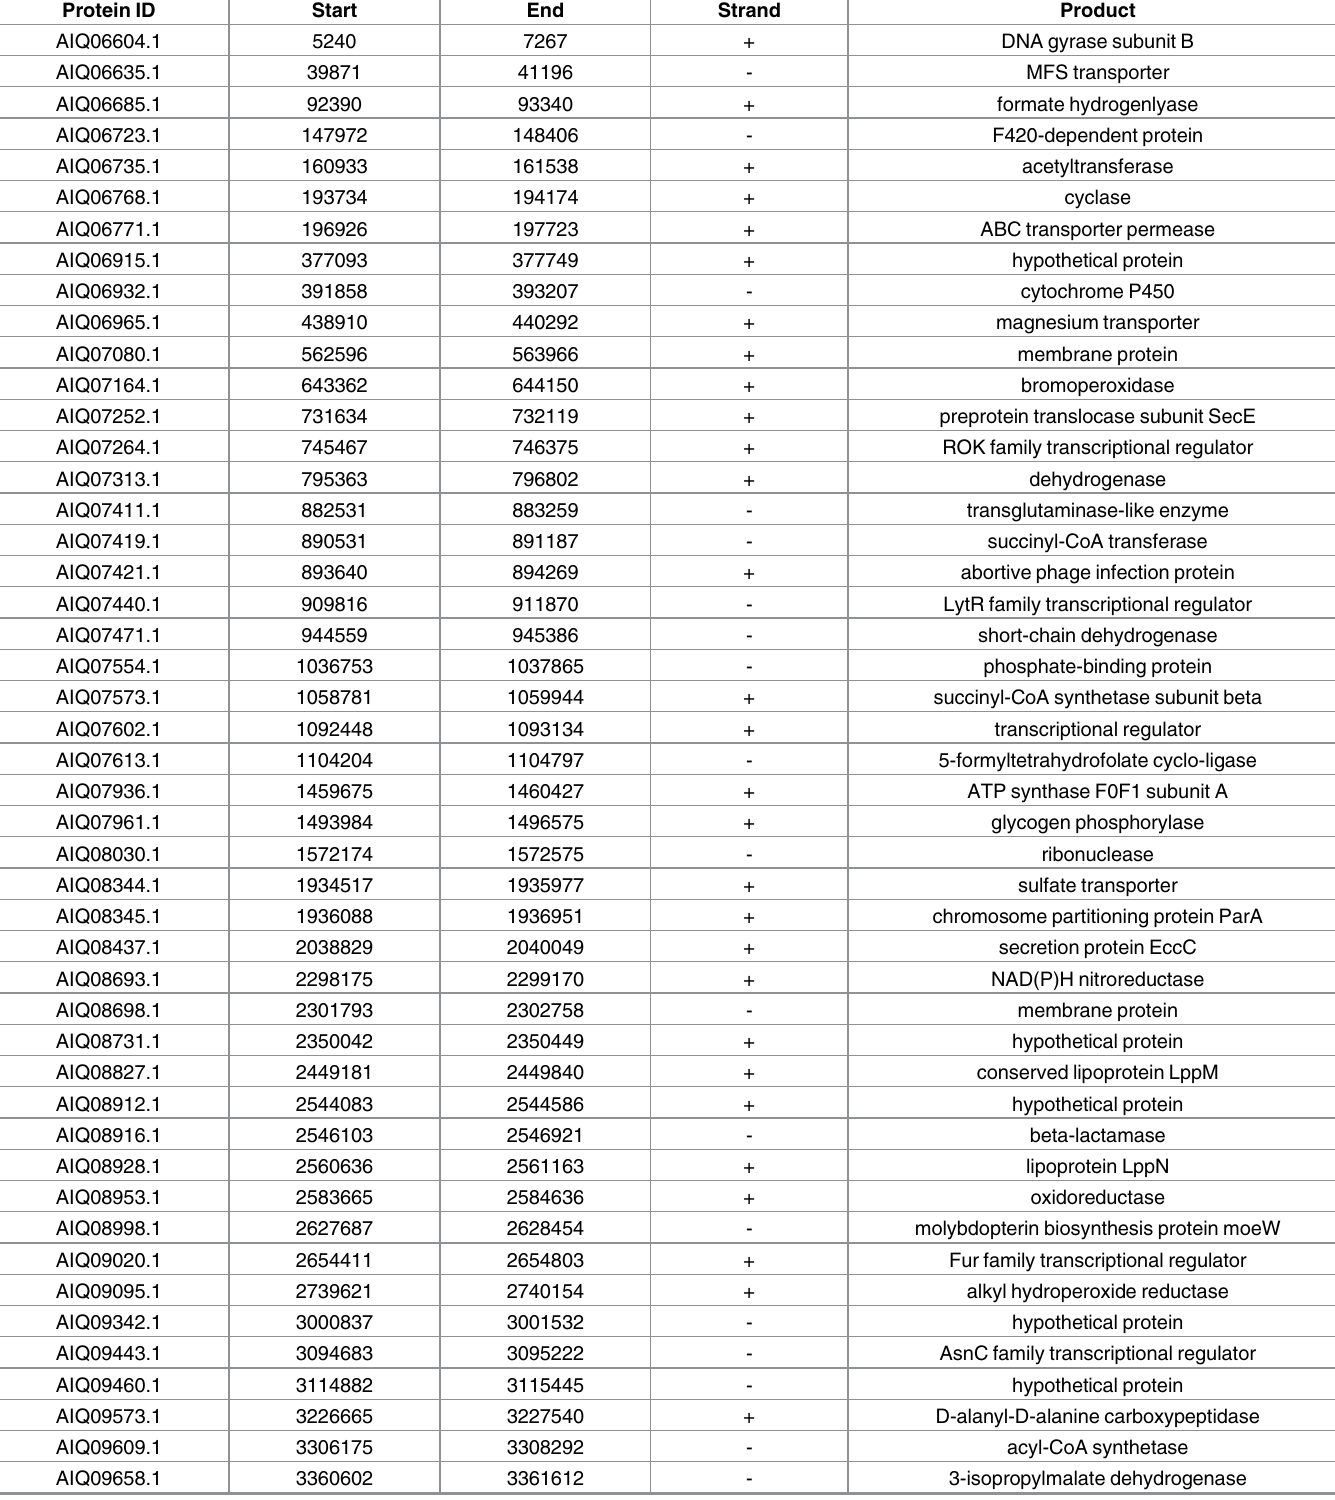
Table 3. List of proteins under positive selection in Manila family 96121 but not Beijing family